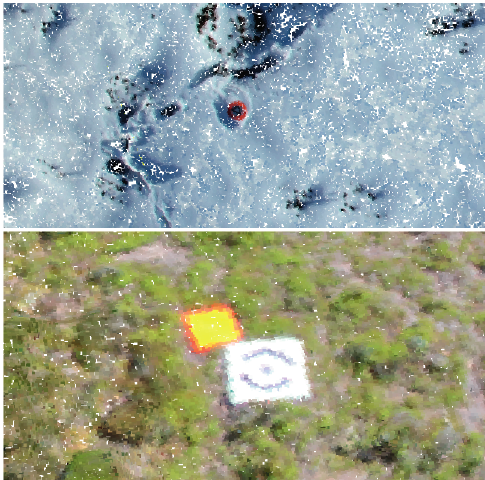
Figure 6. Bootstrap validation was done by finding the photo identifiable control points in the reconstructed point cloud (shown above), and comparing the estimated coordinates with those measured from RTK